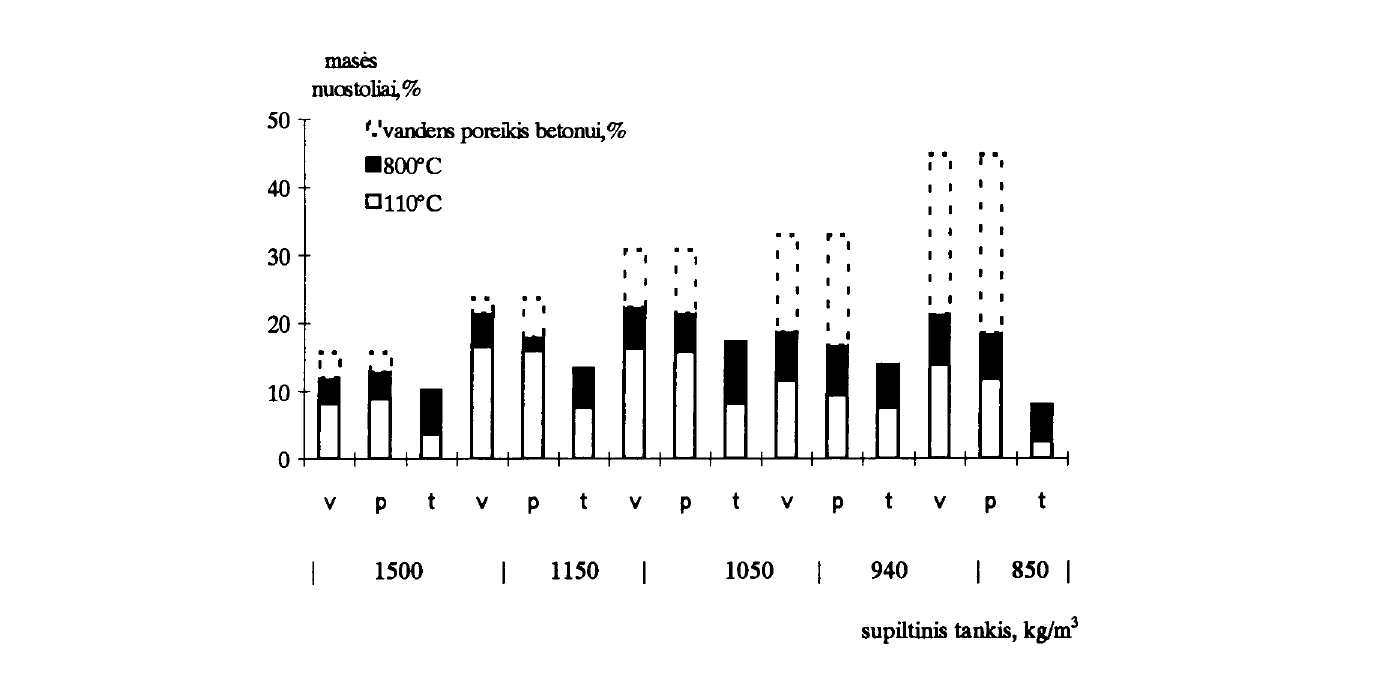
Fig. 2. Loss of gunite mass dependence on firing temperature and dry mixture bulk density: v - VIbration; p - ramming; t-